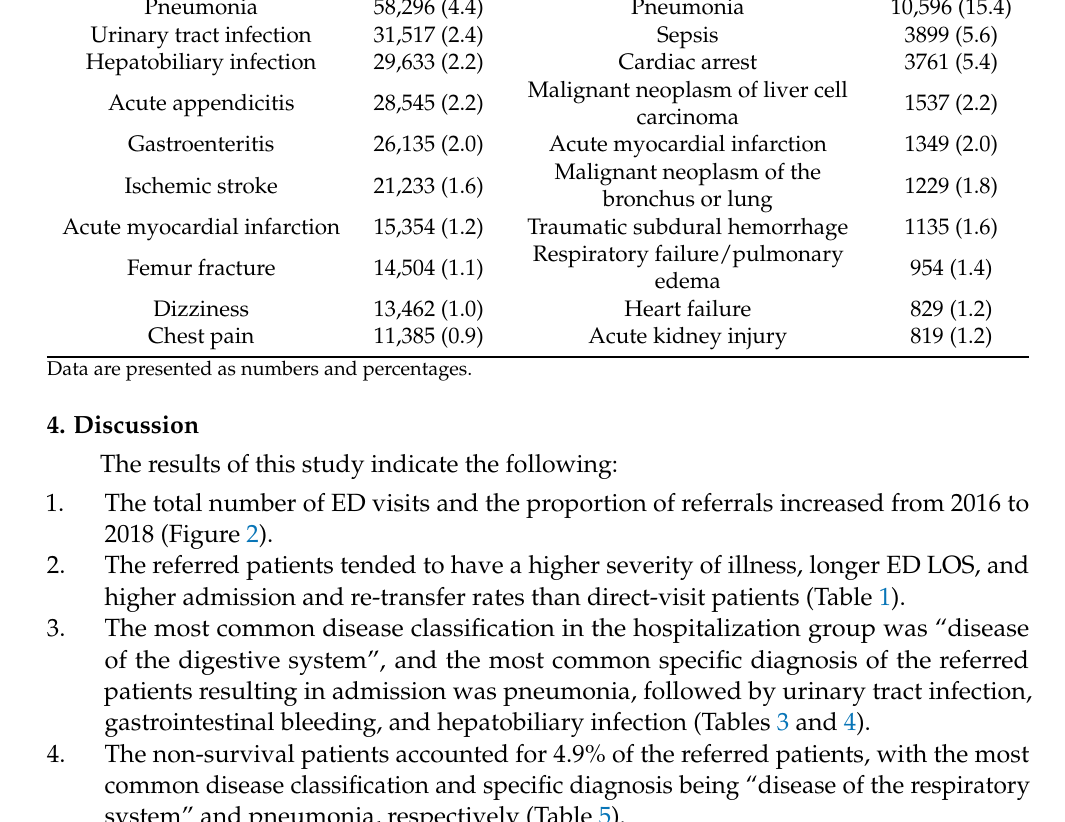
Table 5. Top 10 common diagnoses in referred visits of survival and non-survival patients. Survival Patients ( n = 1,327,156, 94.8%) Non-Survival Patients (69,025, 4.9%) Pneumonia 58,296